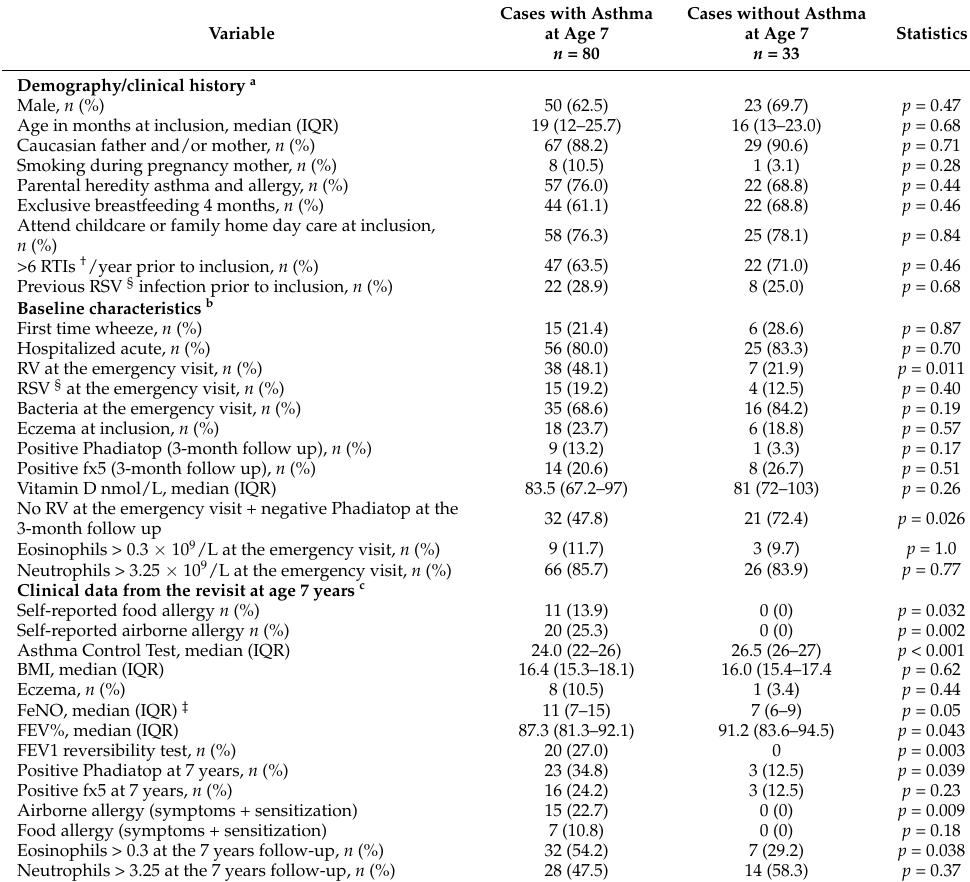
Table 2. Cases were divided into two groups based on whether they had asthma at the revisit at age 7 years or